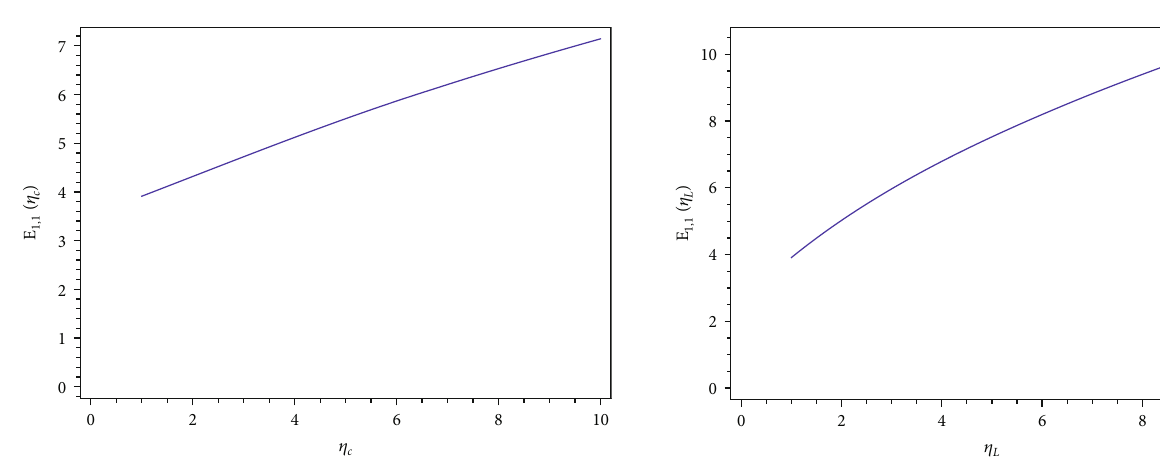
Figure 1: n = l = k = M = q = a = b = η Eq. (17) is the bicon fl uent Heun ’ s di ff erential equation Heun polynomials.